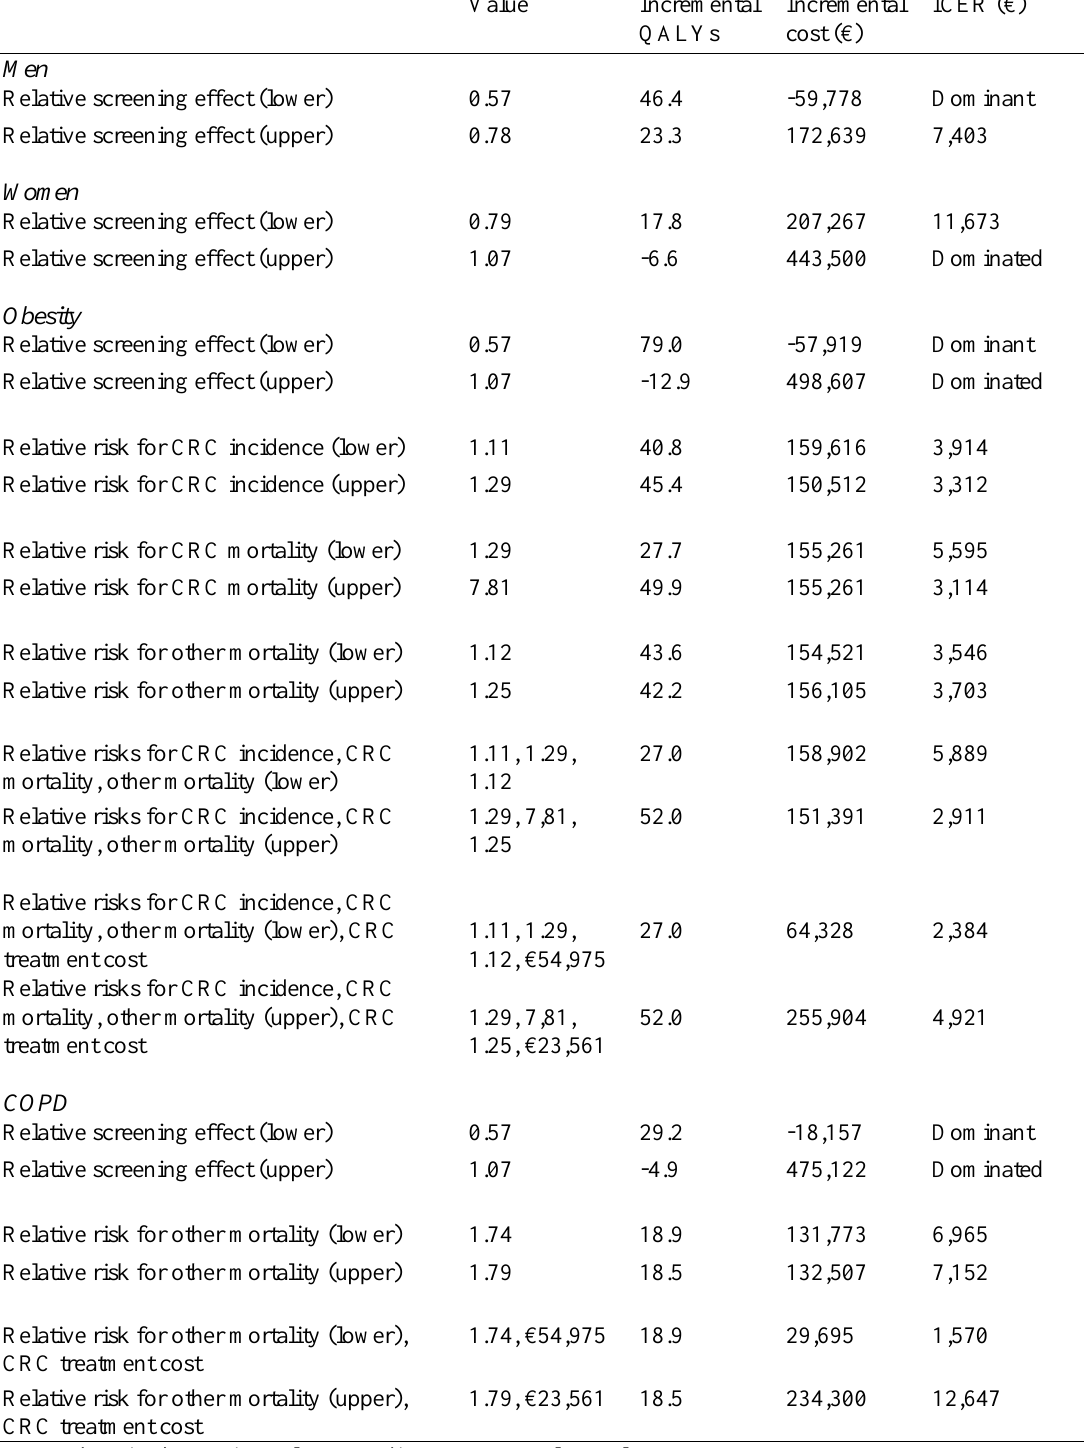
Table 3: Discounted incremental costs, quality-adjusted life years (QALY) and incremental cost-effectiveness ratios (ICER) associated with the one-way and multi-way analyses for screening for CRC involving once-only sigmoidoscopy at age 60 years compared to no screening for the comorbidity subgroups related and unrelated to CRC with the highest expected benefit of screening within their category, i.e., obesity and COPD. Value Incremental QALYs